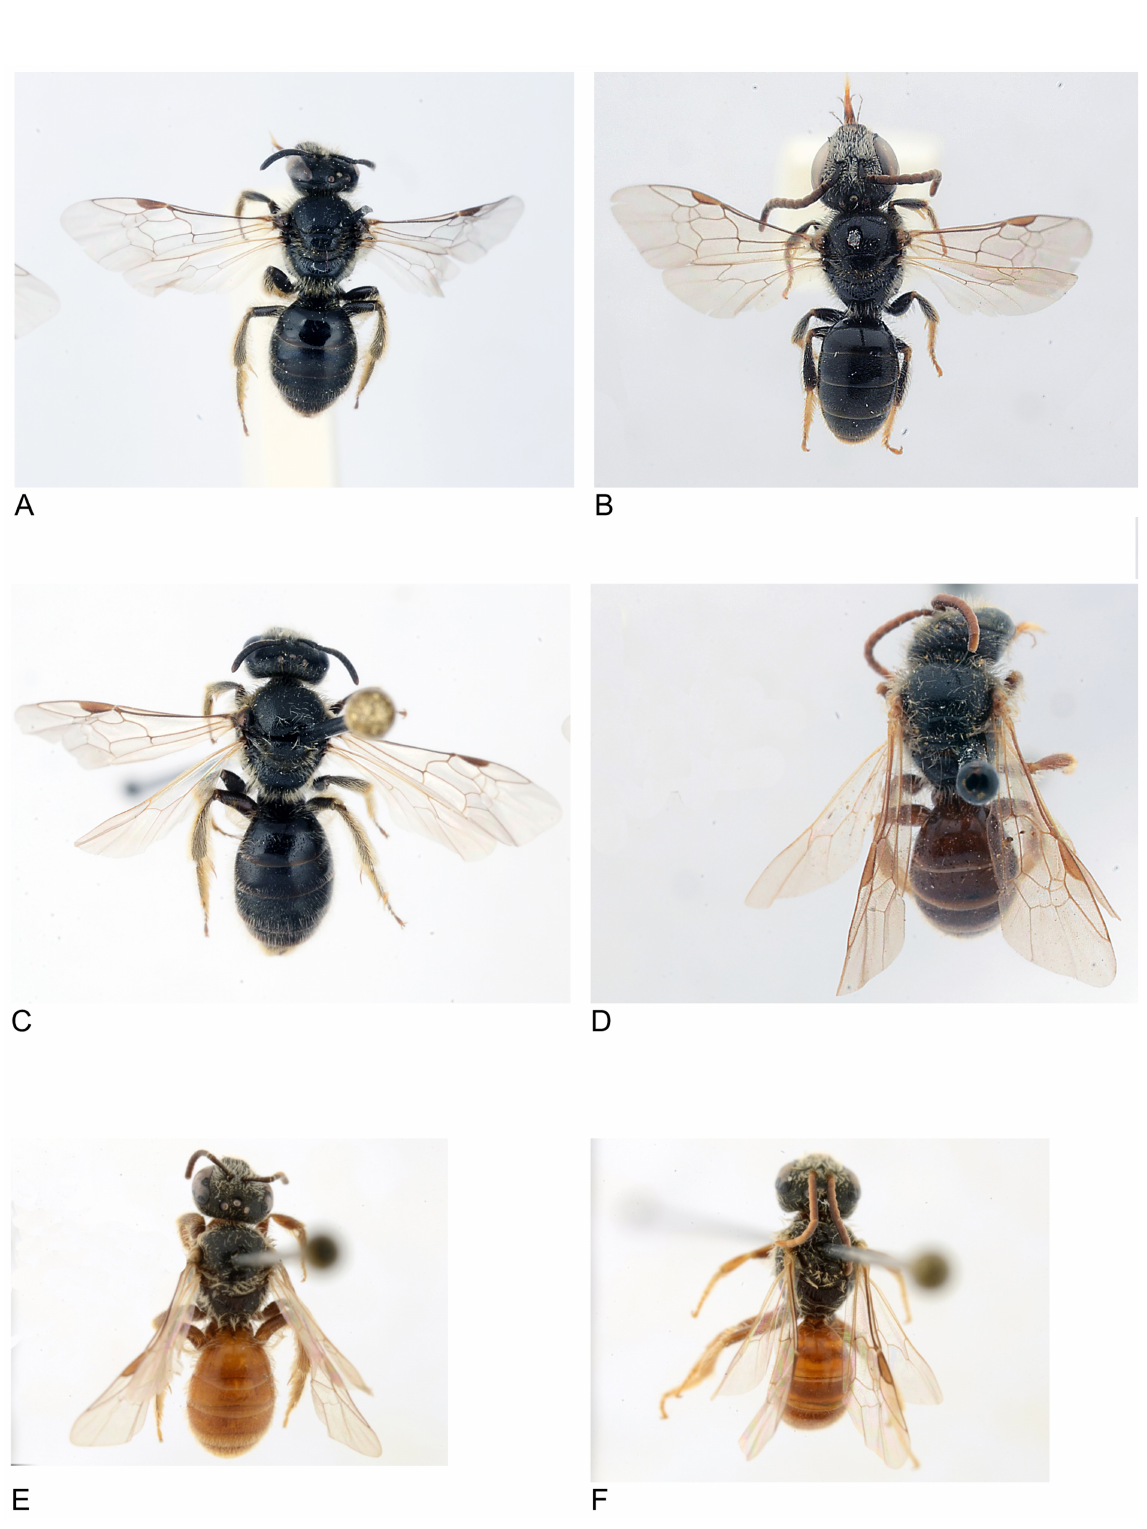
Fig. 2. Colouration and relative size of the species and subspecies. A–B . Lasioglossum villosulum (Kirby, 1802), ♀ and ♂. C–D . L. medinai (Vachal, 1895), ♀ and ♂ (holotype). E–F . L. villosulum arabicum Ebmer, 2008, ♀ and